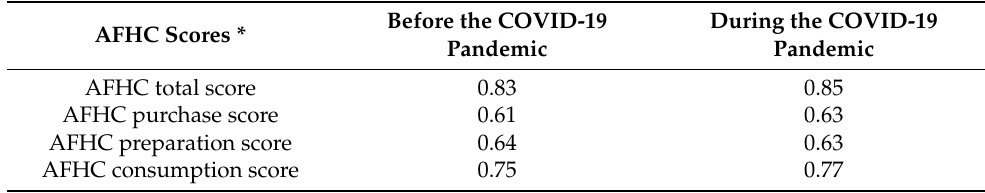
Table 1. The Cronbach’s alpha coefficient for dietary habits scores calculated on the basis of the AFHC for purchase, preparation, consumption and total habits, within the PLACE-19